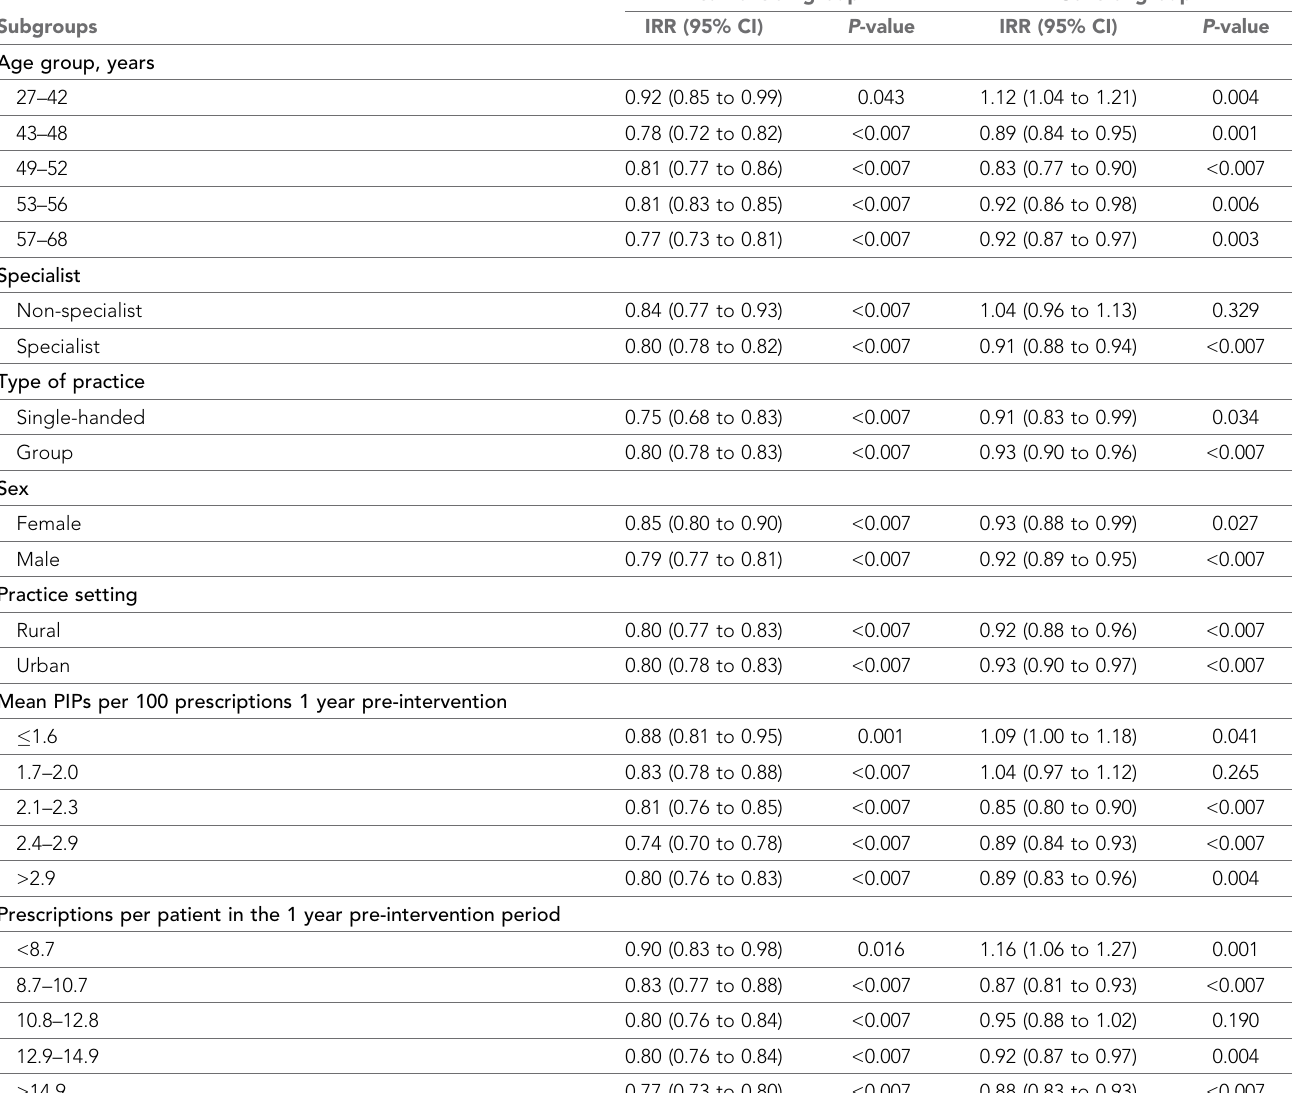
Table 3. Subgroup analyses comparing changes in prescription rates of PIPs by the seven GP-related characteristics. Unadjusted IRRs and their 95% CIs obtained from the Poisson regression model with cluster effects at CME group level showing the changes in PIPs within the subgroups, a =